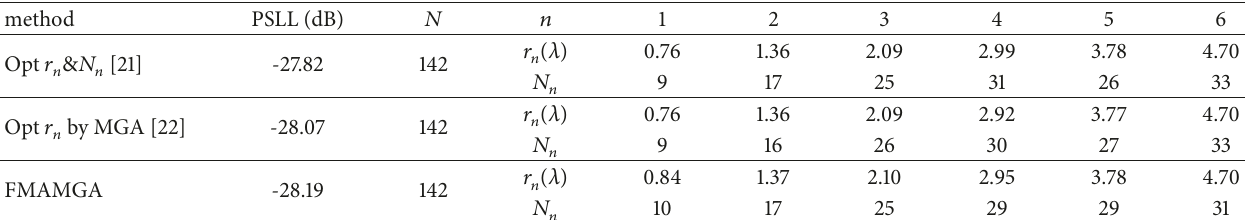
Opt 𝑟 𝑛 by MGA [22]